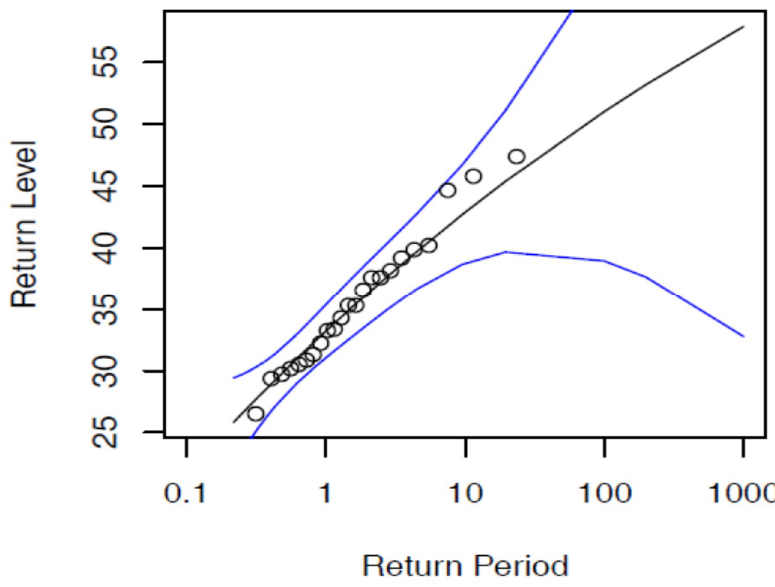
Figure 15. Estimation of the return periods of the annual maxima of rainfall events (mm). The circle represents the observed values over 23 years (1988–2010) and the blue curves refer to the confidence level.